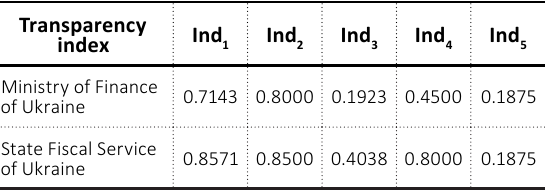
Table 7. Indicators of transparency of the Ministry of Finance of Ukraine